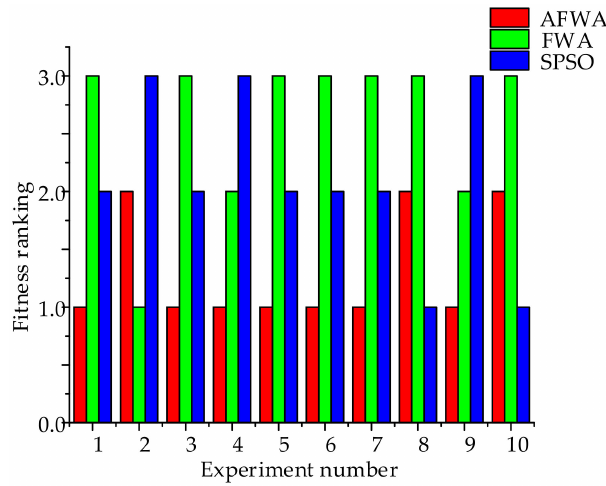
Figure 11. Algorithm fitness ranking of the second case.